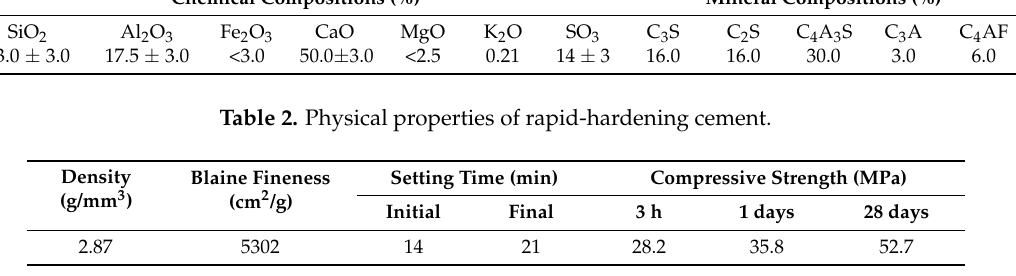
Table 3. Physical properties of coarse